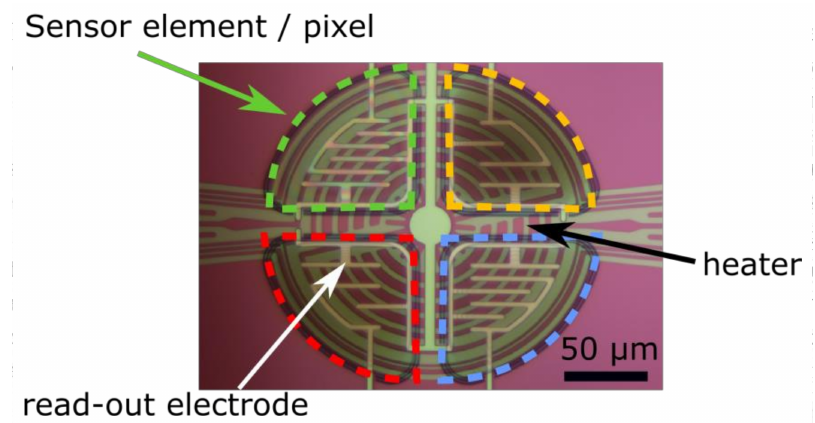
Figure 2. Micrograph showing the four sensing elements (indicated by colored shapes), the read-out electrodes and the heater element.